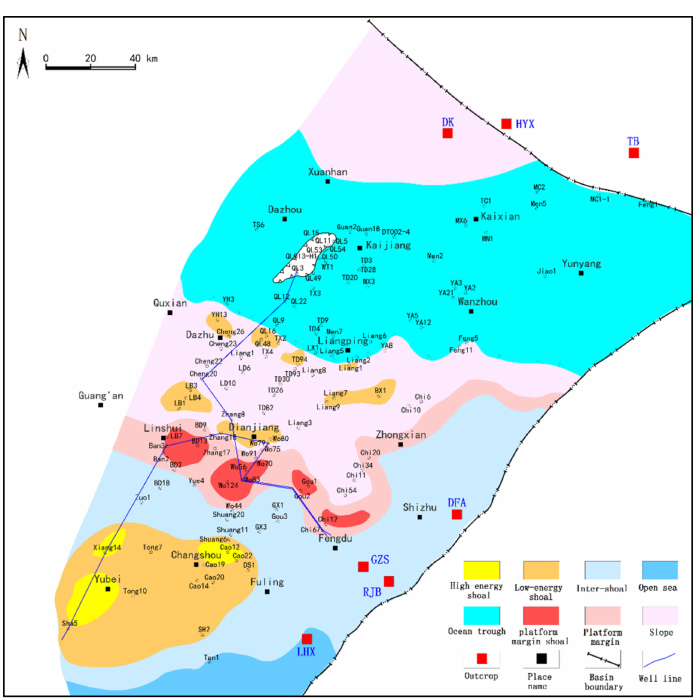
Figure 14. Planar distribution of sedimentary facies in the P 2 m 2